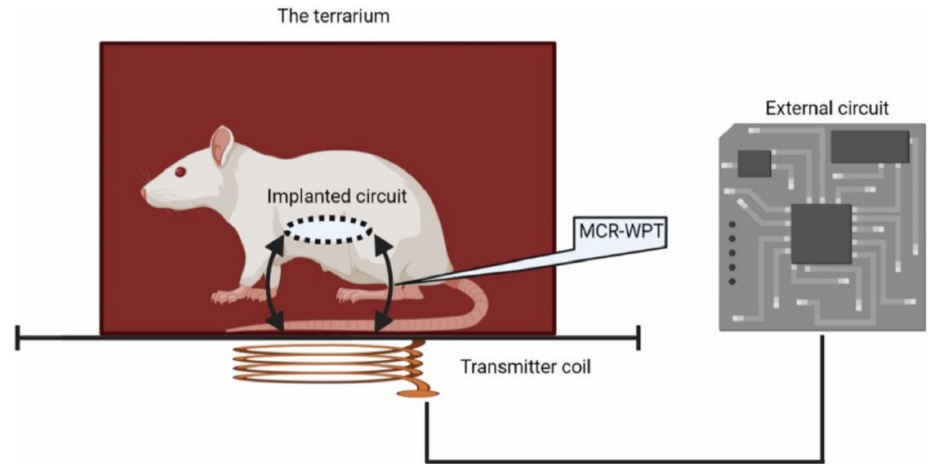
Figure 1. A fully implantable electrical nerve stimulator: the implanted circuit with a rectifier and receive coil (T X ), the transmit coil (R X ) under the terrarium supplies energy by using magnetically coupled resonant wireless power transfer (MCR-WPT), the external circuit is used to generate